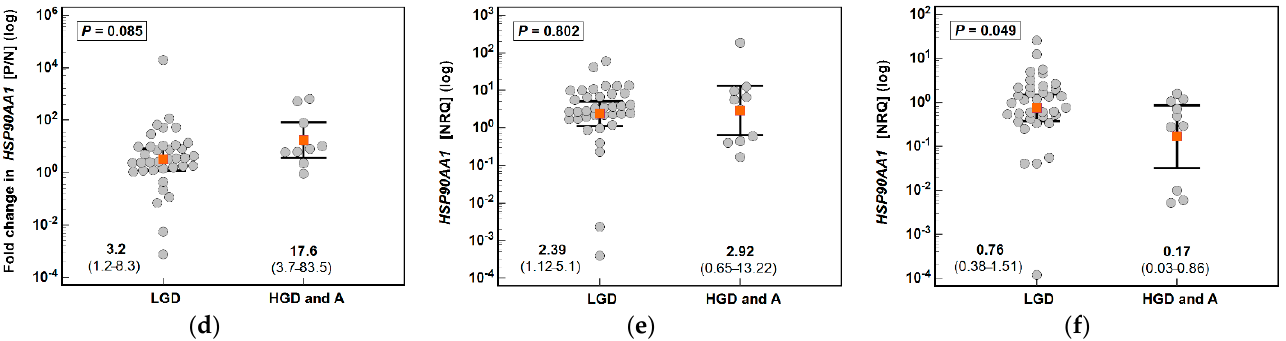
Figure 3. Association of HSP expression with polyp grade of dysplasia: ( a ) fold change in HSPA1 expression; ( b ) HSPA1 expression in polyps; ( c ) HSPA1 expression in polyp-adjacent (normal) tissue; ( d ) fold change in HSP90AA1 expression; ( e ) HSP90AA1 expression in polyps; ( f ) HSP90AA1 expression in polyp-adjacent (normal) tissue. Data presented on loga- rithmic scale as geometric means (red close squares) with 95% confidence interval (whiskers) and analyzed with t -test for independent samples. P/N, polyp-to-normal ratio; NRQ, normalized relative quantity; LGD, low grade dysplasia; HGD, high grade dysplasia; A, adenocarcinoma in polyp.